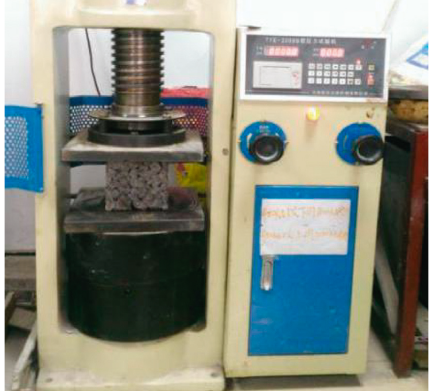
Figure 14: Compressive strength